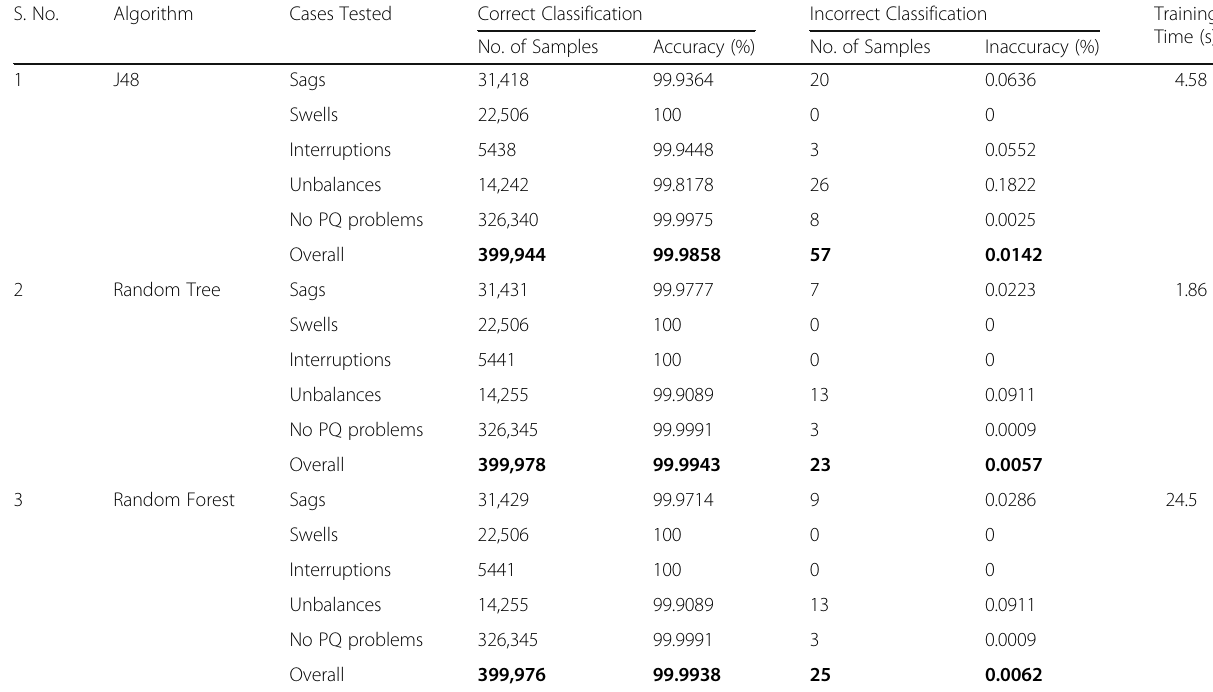
Table 3 Comparison of Data Mining Algorithms with 4 attributes for stratified 10-fold cross-validation S. No.